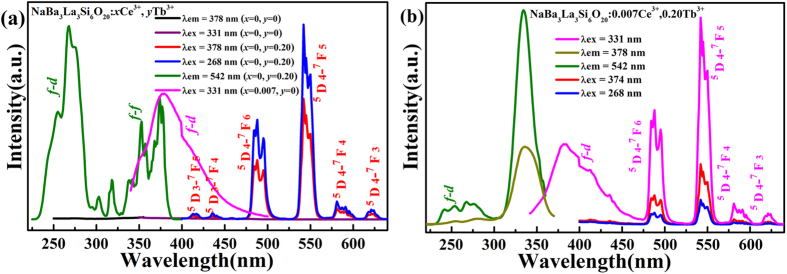
The PLE and PL spectra of the NaBa3La3Si6O20:xCe3+, yTb3+ phosphors (a), and the NaBa3La3Si6O20:0.007Ce3+, 0.20Tb3+ phosphor (b).